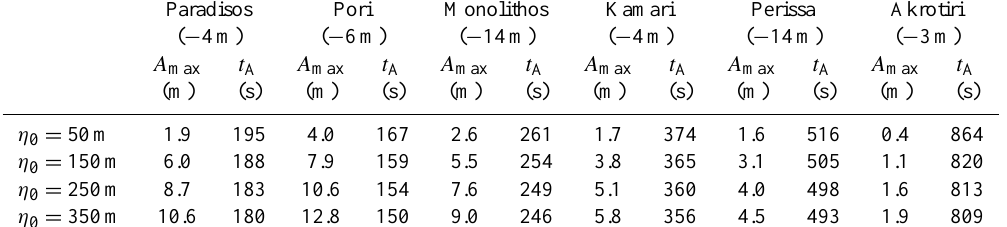
Table 1. Maximum wave amplitudes A max and arrival times t A for different explosion powers (i.e. different sizes of initial water crater rim η 0 ) at six different locations on Santorini. Values at gauges near the main towns (closer than about 900m) on the coast of the island are reported (cf. Fig. 2). Number in parenthesis reports the water depth at a given gauge.